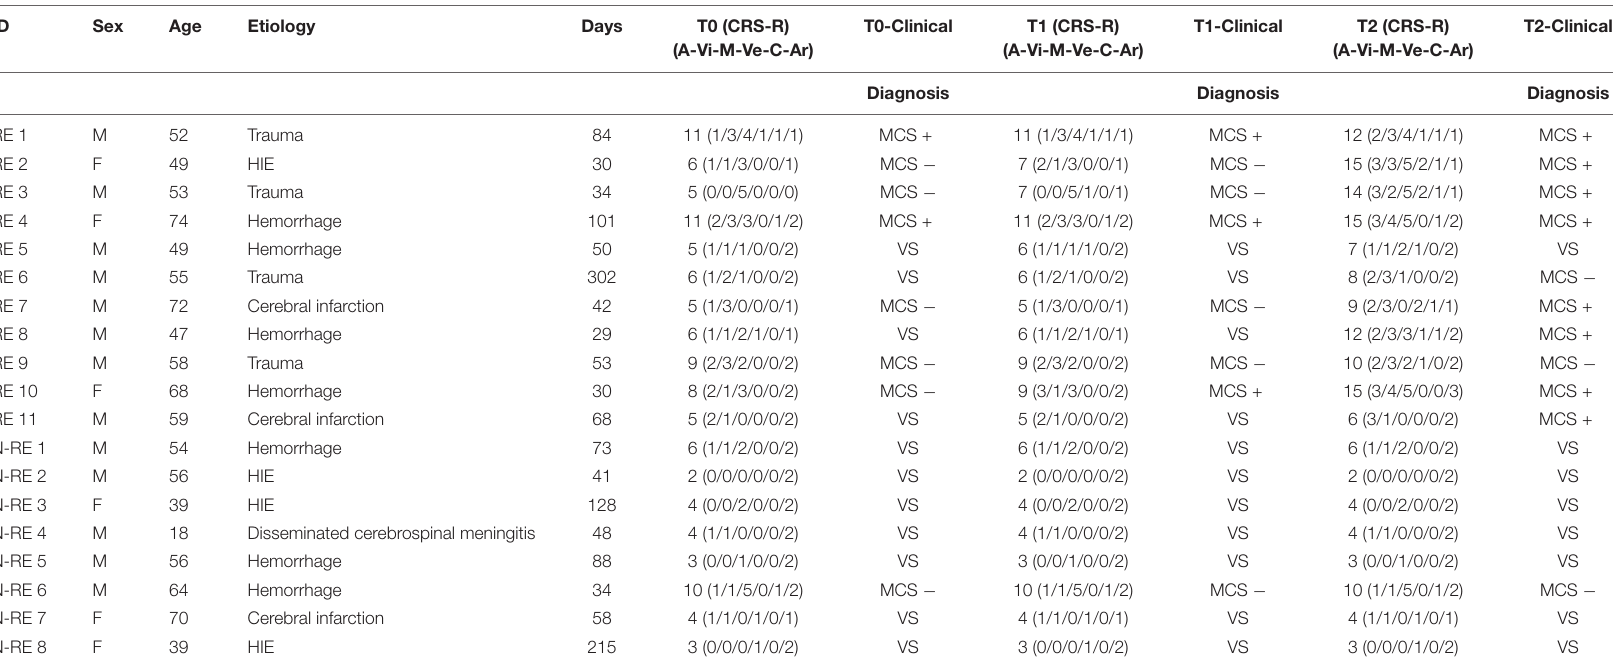
TABLE 1 | Demographic details for the